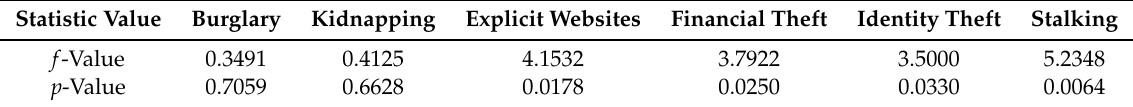
Table 11. Statistical analysis of gender related differences of danger assessment results using the Analysis of variance (ANOVA) method. In the table we see the f -value and p -value for the age groups: 18–25 & 26 and